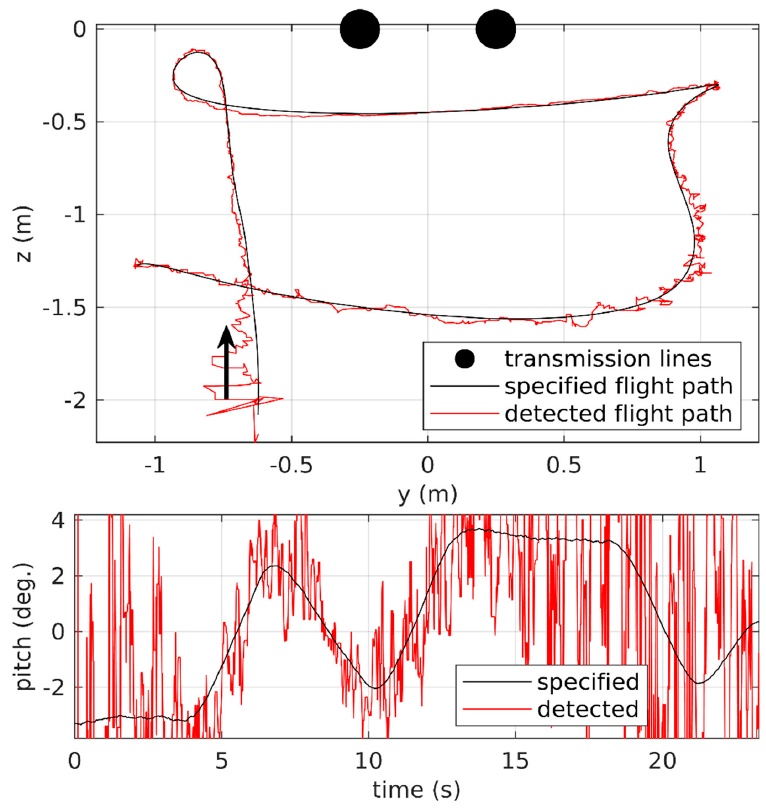
Figure 11. Localization quality, poor shielding: σ = 8 μ T.